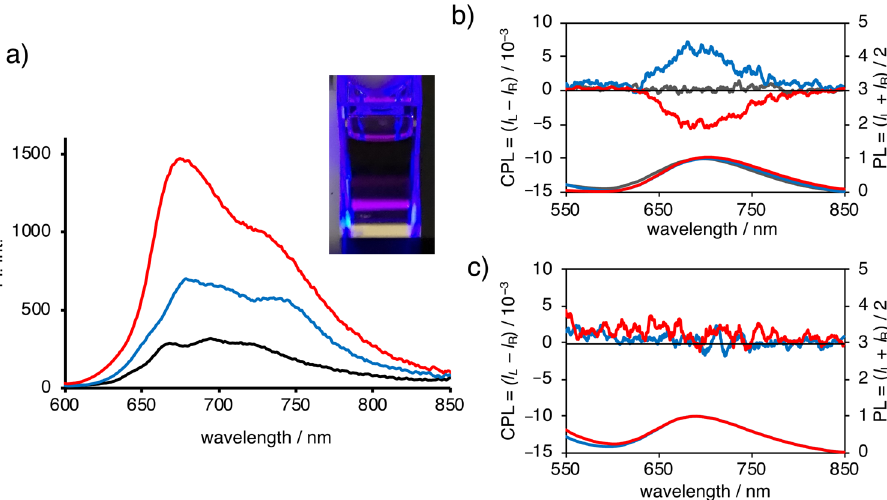
Figure 6. FL and CPL/PL spectra of X70A and X70F in toluene. ( a ) FL spectra of X70A (blue line), X70F (red line), and C 70 (black line) in toluene excited at 500 nm with the absorbance adjusted at 0.1. Inset: photographic image of the deep-red FL from X70A1 excited at 450 nm taken using a digital camera (Leica, ASA 6400, f1.8, SS1/4). ( b ) CPL (top) and PL (bottom) spectra of X70A in toluene excited at 410 nm. Blue, red, and grey lines represent the CPL/PL spectra of the first and second fractions of X70A and the intact C 70 , respectively. ( c ) CPL (top) and PL (bottom) spectra of X70F in toluene excited at 500 nm. Blue and red lines represent the CPL/PL spectra of the first and second fractions, respectively. Note that X70F showed no obvious CPL